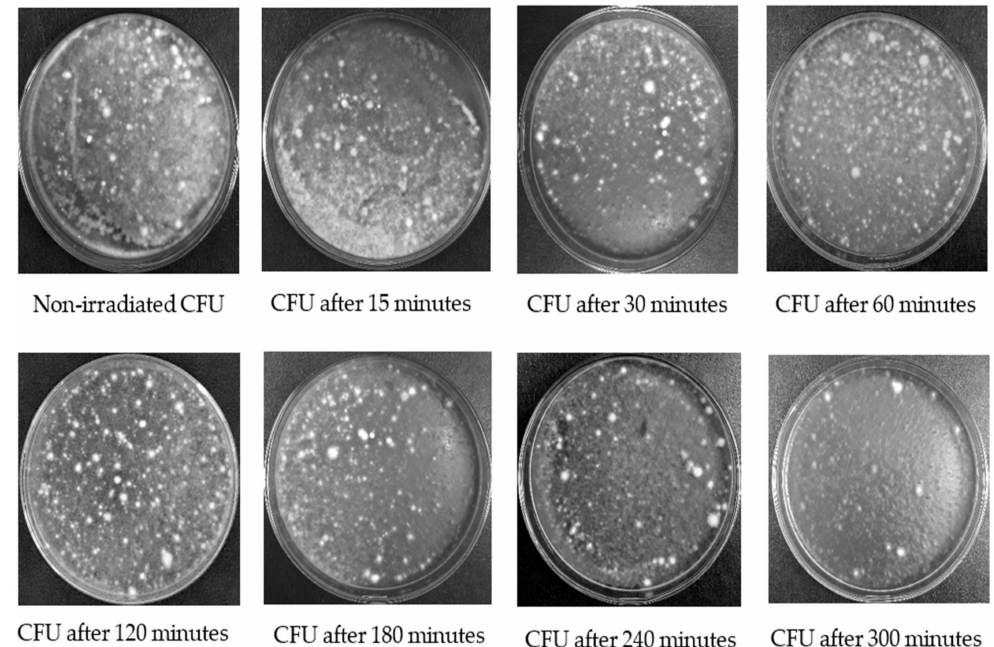
Figure 1. A comparison for CFU of the fungus isolate “MaSA-1” growth on PDA medium after UV-B irradiation at different exposure